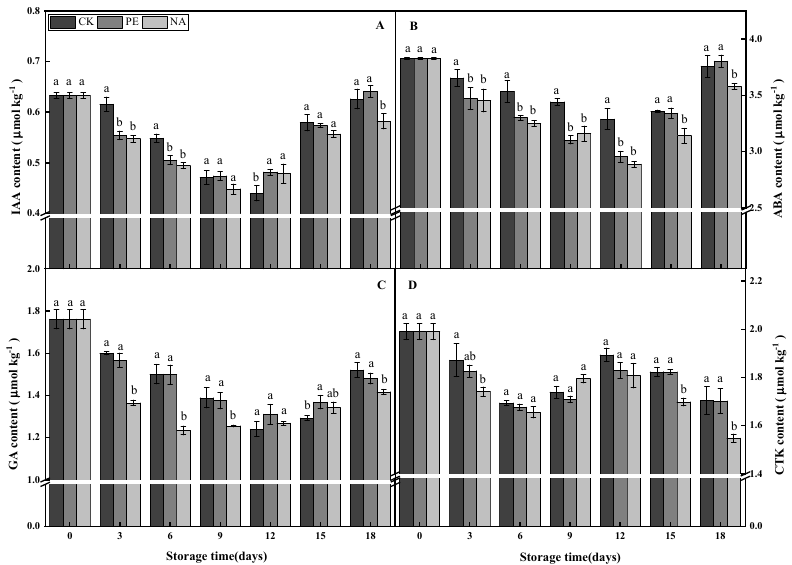
Figure 7. Effects of different types of packaging on IAA ( A ), ABA ( B ), GA ( C ), and CTK ( D ) levels. Abscisic acid (ABA) is an endogenous plant hormone that also affects cell elongation, mainly by inducing lateral elongation [24]. In Serpil et al., ABA was present in Pleurotus florida (Basidiomycetes), and the growth rate of this fungus was negatively correlated with ABA synthesis [25]. In recent years, studies have shown that ABA also exists in the fungi of basidiomycetes, such as Volvariella volvacea and Agaricus bisporus [18,26]. It can be seen from Figure 7B that the ABA content of F. velutipes first decreased and then increased during 18 d of storage in all three groups. However, the ABA content of the nano-packag- ing group was always lower than that of the CK group, and on day 12 of storage, the gap between the nano-packaging and CK groups reached a maximum (87.8% that of the CK group). Moreover, although there was no difference in ABA content between nano-pack-